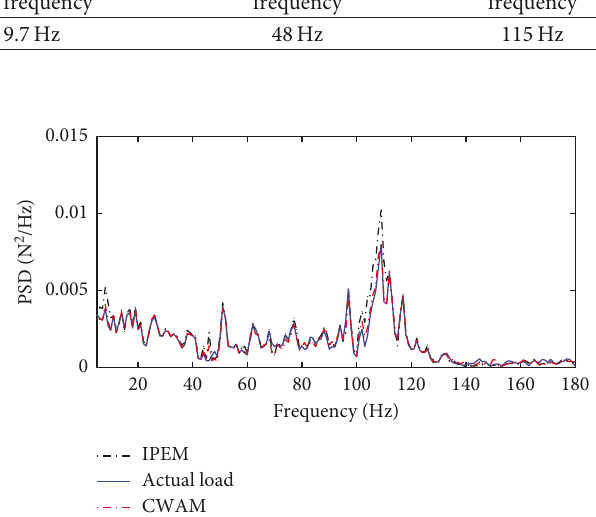
Table 3: First three natural frequencies of the cantilever beam. Fundamental